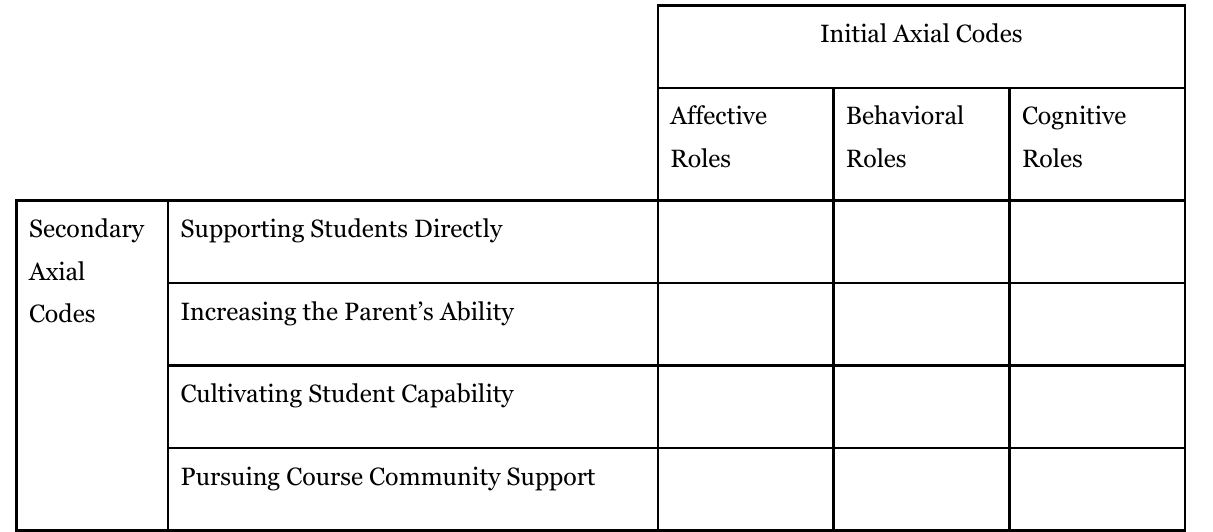
Matrix Depicting Intersections Between Initial and Secondary